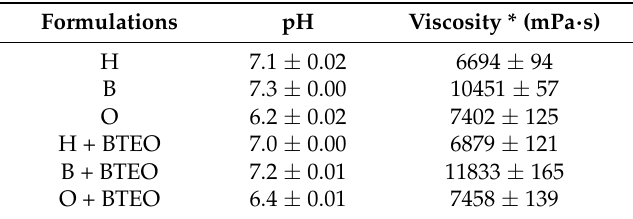
Table 1. pH and viscosity of the prepared formulations without (H, B, O) and containing essential oil of Bidens tripartita (H + BTEO, B + BTEO, O +